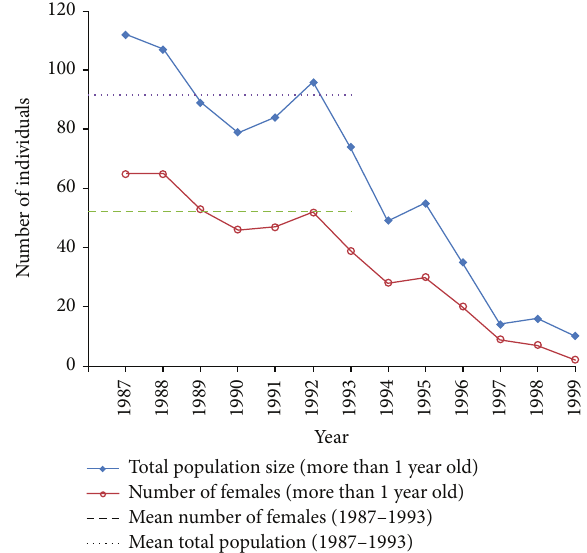
Figure 3: Northern Idaho Ground Squirrel population at Squirrel Valley, Idaho (data from